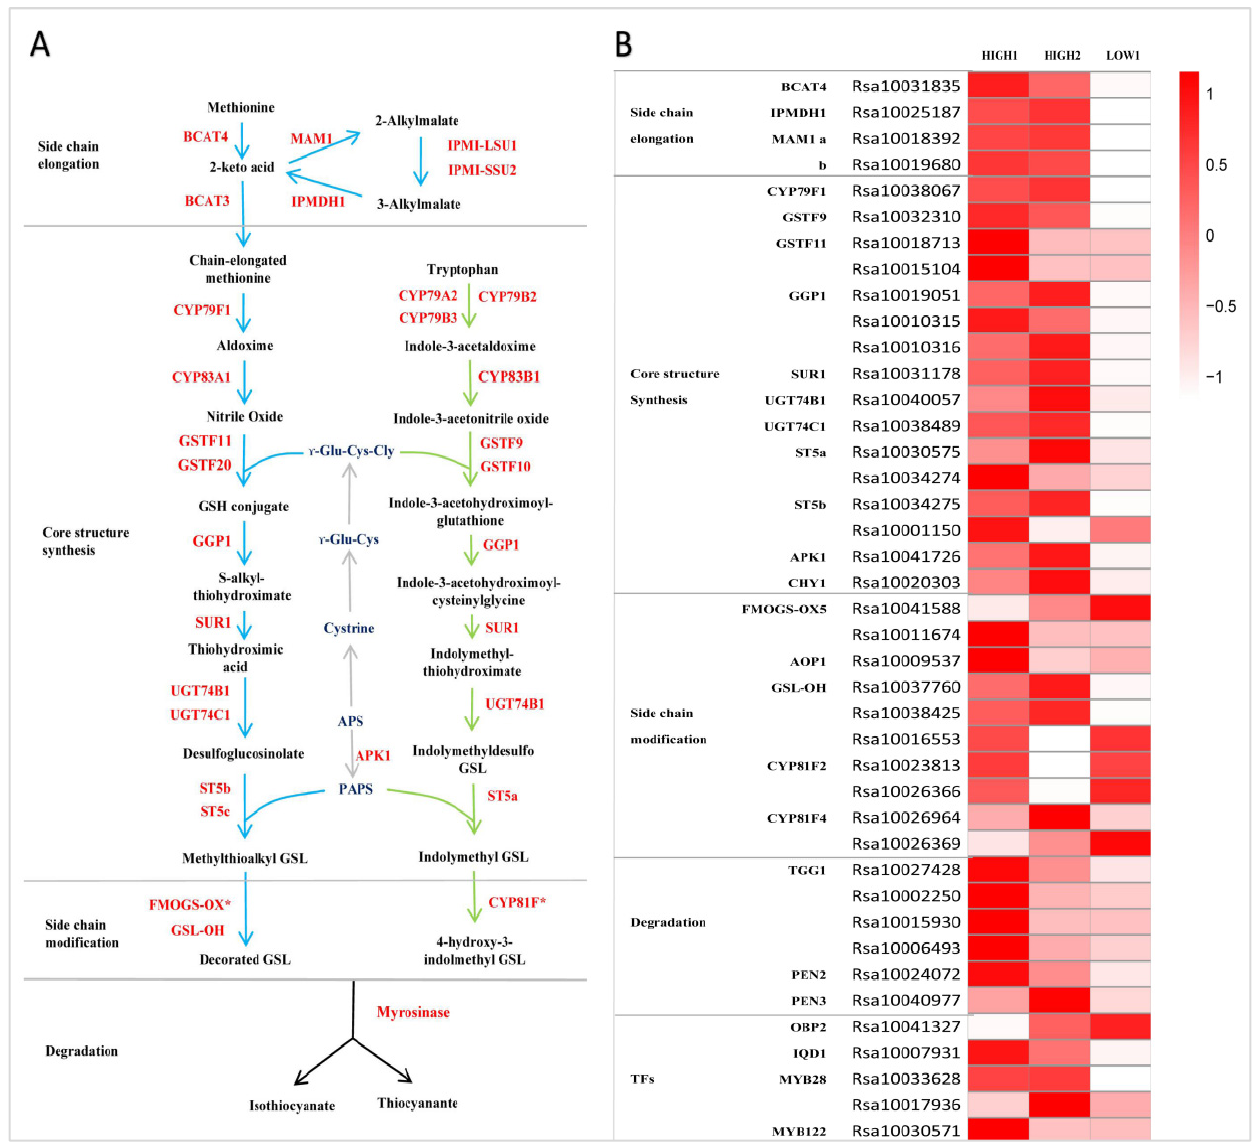
Figure 3. GSLs pathway and its expression pattern in radish fleshy taproots. ( A ) GSLs pathway map. ( B ) Heatmap showing the expression level of genes encoding enzymes and regulators in the GSLs pathway. The color code indicates the differential expression values, and the scale on the right represents the gene expression levels based on the log2 values of reads per kilobase of exon model per million mapped reads (FPKM). BCAT, branched-chain amino acid aminotransferase; MAM, me-